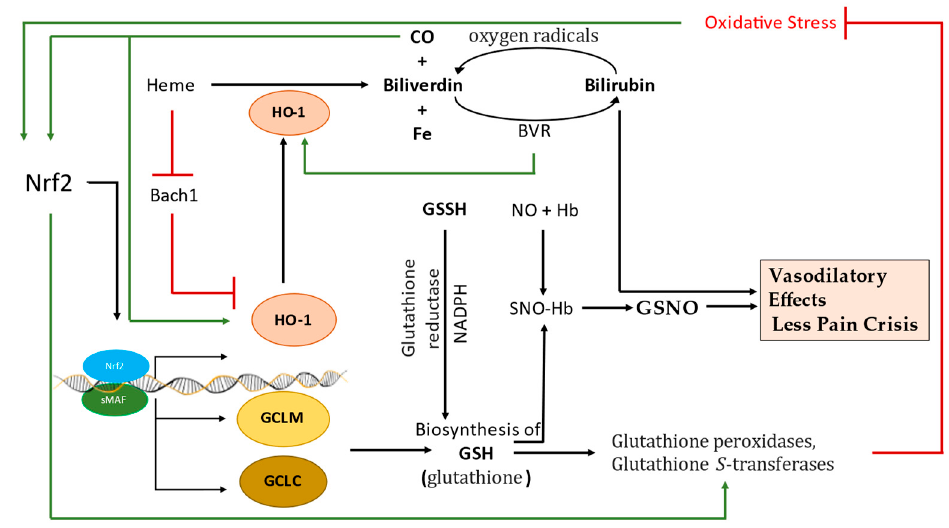
Figure 5. Flow diagram depicting the complete pathway indicating how Nrf2 directly or indirectly ameliorates SCD complications through HO-1 and GSH. HO-1 is a crucial enzyme involved in heme catabolism and cleaves heme into CO, Fe cations and biliverdin. CO positively induces Nrf2 and HO-1 expression, which further help to maintain oxidative balance. On the other hand, biliverdin converts to its reduced form called bilirubin by biliverdin reductase (BVR). Bilirubin the vasodilator byproduct can reduce pain crises. Similarly, Nrf2 maintains the biosynthesis of GSH, a substrate for the antioxidant enzymes GPx and GST. GSH also has an affinity towards NO and pulls the NO from nitroso-Hb to form GSNO. GSNO has been studied as the one of the strongest naturally occurring vasodilatory agents.